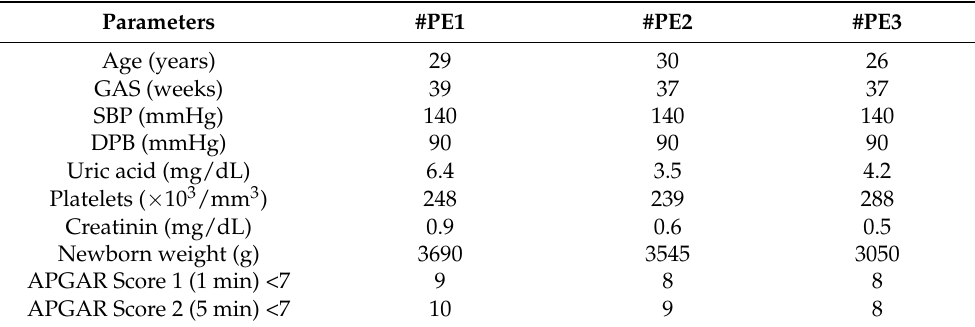
Table 2. Clinical parameters of the umbilical arteries from each PE patients.